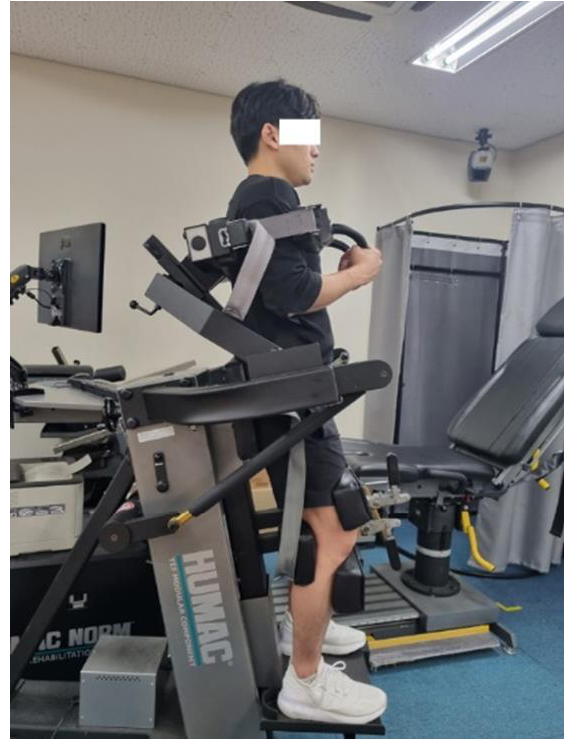
Figure 2. Measurement posture of trunk isokinetic strength. Table 2. 7 weeks core exercise